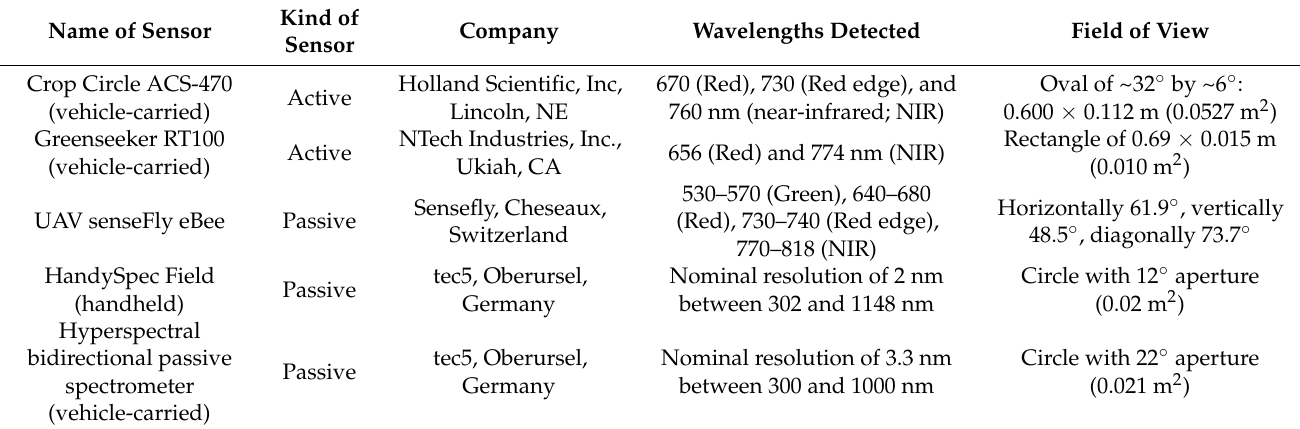
Table 2. Spectral reflectance sensor information.